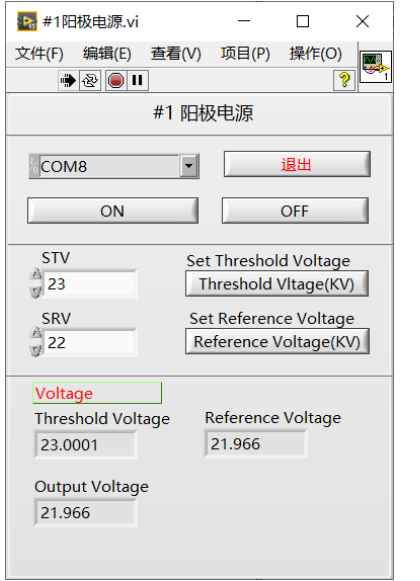
Fig. 3. The host computer control interface of the GYCOM anode power supply.